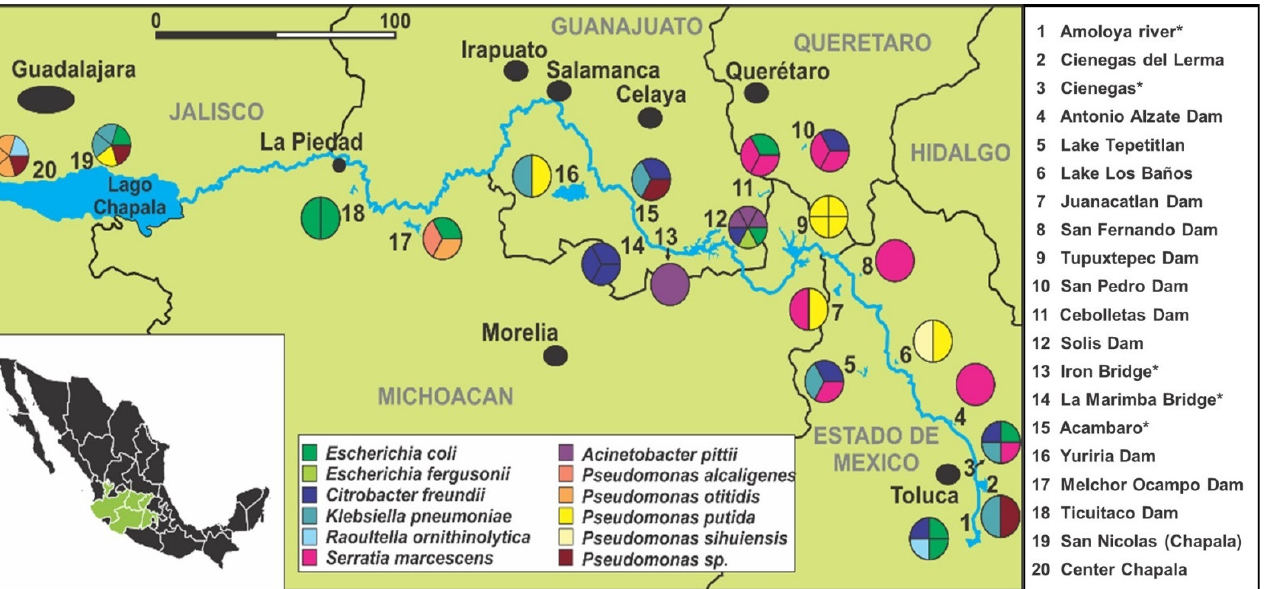
Figure 2. Geographical distribution of bacterial species identified along the five states that are part of the Lerma River basin. The diversity and number of species isolated from each site is represented in circle charts. In the sites with asterisks, samples were taken directly from the Lerma River.